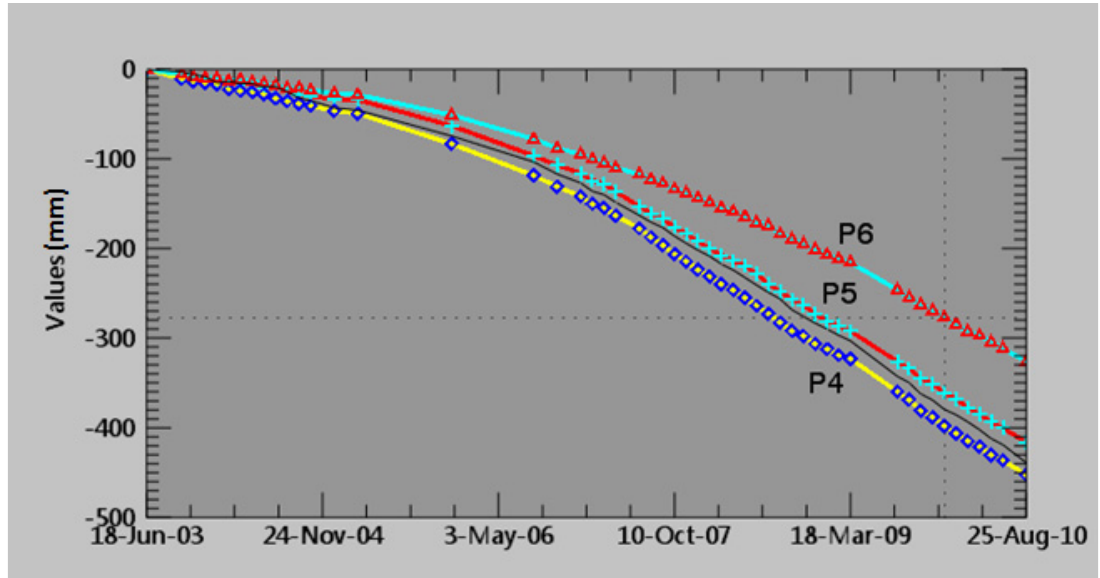
Figure 6. Displacement history for the three typical points (P4, P5 and P6, marked in Figure 4) within the subsidence funnel zone II.